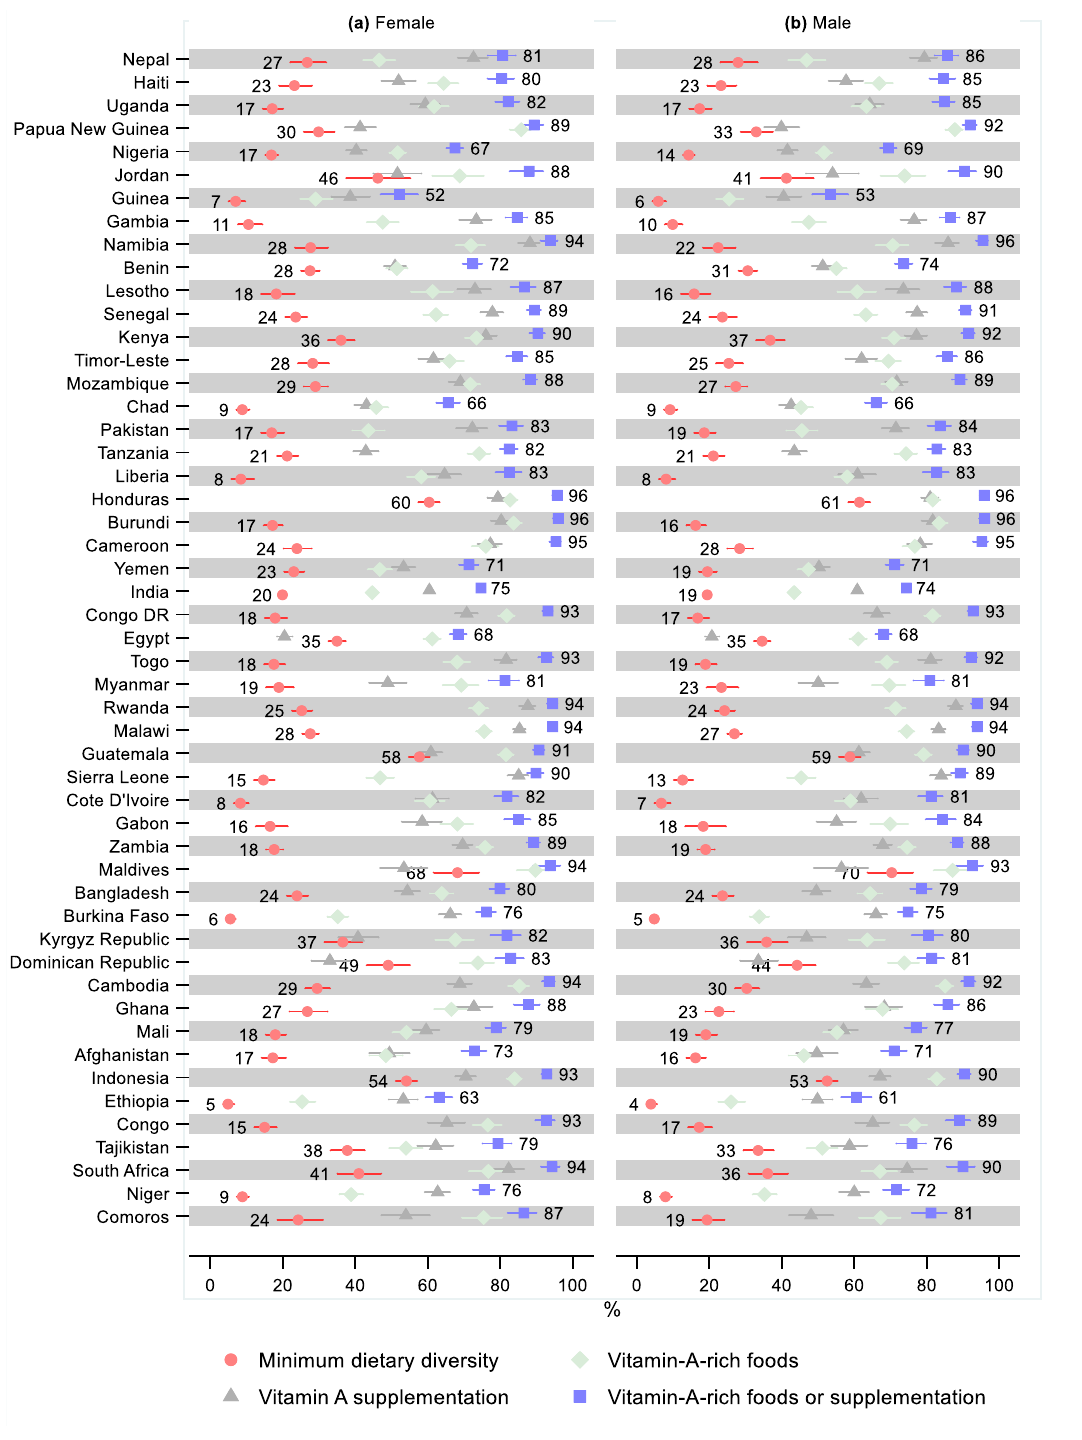
Figure 4. Percentage of children 6–23 months old that received the minimum dietary diversity, vitamin-A-rich foods, vitamin A supplementation, and either vitamin-A-rich foods or vitamin A supplementation by sex and country. Notes: 95% confidence intervals are shown. Countries are ordered from largest to smallest relative sex difference in the percentage of children that received either vitamin-A-rich foods or supplementation. Some confidence intervals may be narrower than the symbol for the estimate and therefore not visible. See Tables S5–S8 in the Supplement for the tabulated estimates and confidence intervals. See Figures S5–S8 in the Supplement for the plotted relative differences.